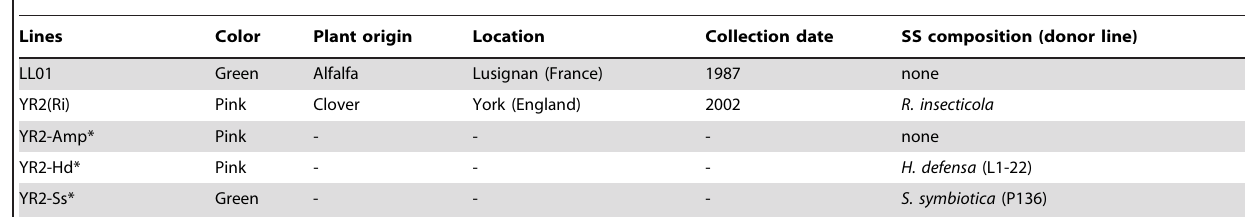
Table 1. Origin and characteristics of the aphid lines.